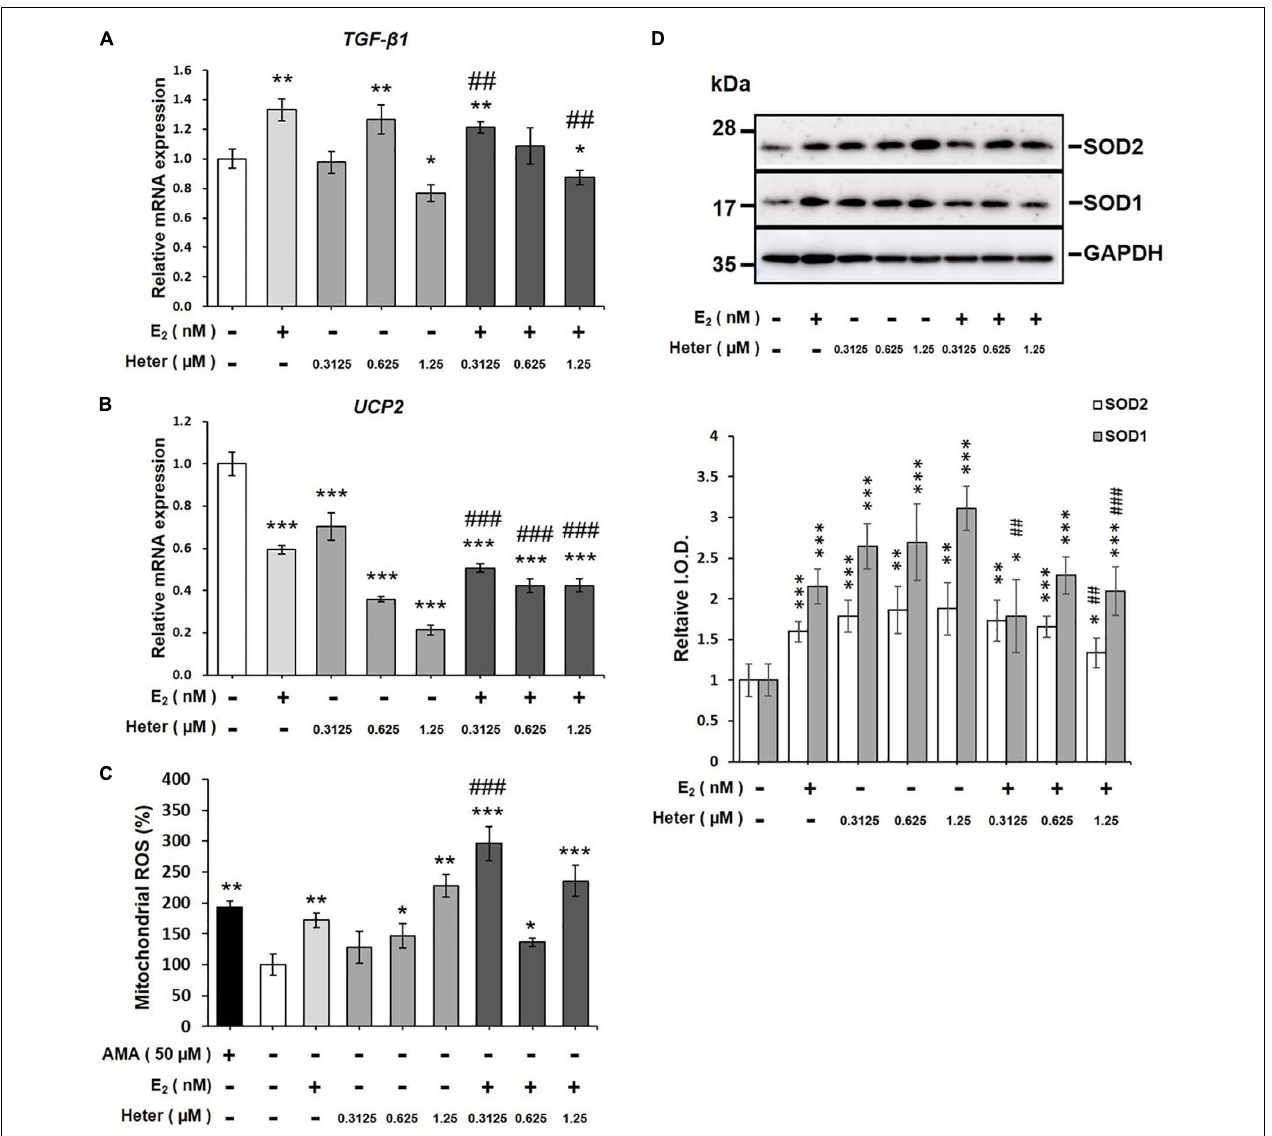
FIGURE 5 | Estrogen and heteronemin regulate expressions of TGF- β 1 and UCP2 and induce mitochondrial reactive oxygen species (ROS) production in MCF-7 cancer cells. Cells were treated with different concentrations of heteronemin in the presence and absence of 1 nM E 2 for 24 h. Cells were harvested and analyzed for (A) TGF- β 1 expression, (B) UCP2 expression, (C) mitochondrial ROS production, and (D) SODs accumulation. The number of independent studies ( n ) = 4. * p < 0.05, ** p < 0.01, *** p < 0.001, compared to the untreated control. ## p < 0.01, ### p < 0.001, compared to the same dosage of heteronemin treatment